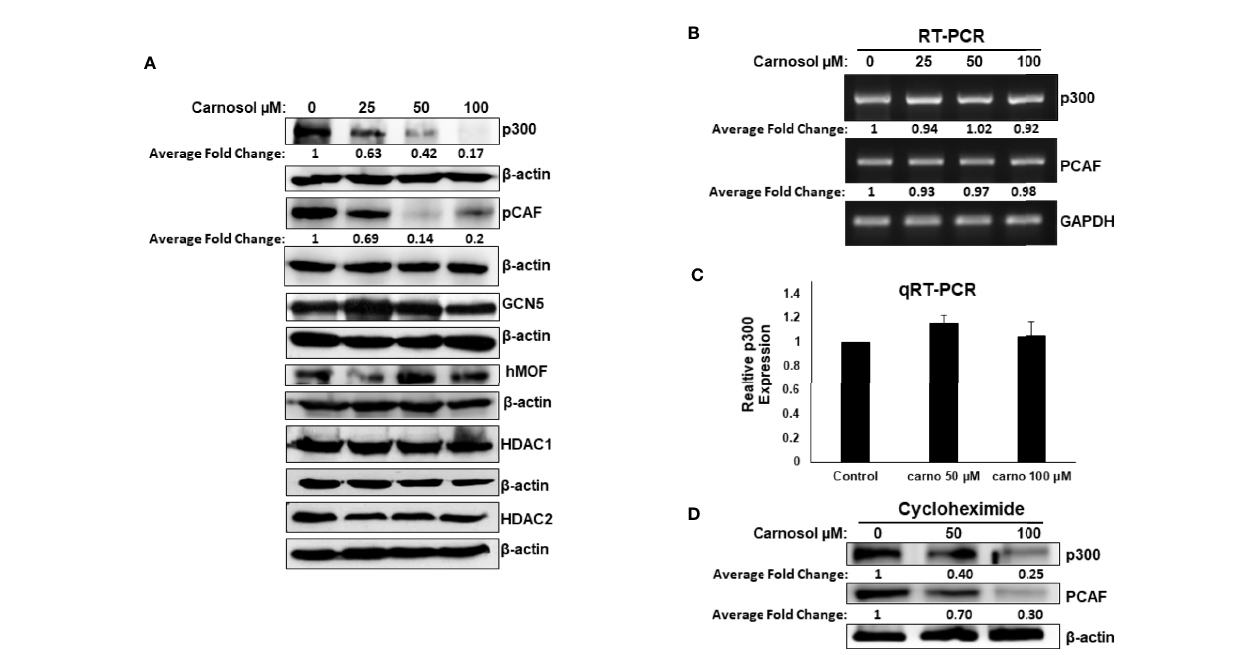
FIGURE 2 | Carnosol downregulates p300 and PCAF in MDA-MB-231 cells. (A) Downregulation of p300 and PCAF protein levels in carnosol-treated MDA-MB-231 cells. MDA-MB-231 cells were treated with vehicle (DMSO) or indicated concentrations of carnosol and whole cell lysates were resolved in 6% SDS-PAGE and subjected to Western blot analysis for the indicated proteins. Data shown are representative of three independent experiments. (B, C) carnosol does not affect the levels of p300 and PCAF mRNA transcripts. Total RNA from carnosol-treated and untreated cells were used to amplify the PCAF and p300 transcripts by RT- and qRT-PCR. RT- and qRT-PCR were repeated twice. (D) Downregulation of p300 and PCAF proteins by carnosol in cycloheximide-pre-treated cells. Cells were pre- treated with cycloheximide, an inhibitor of de novo protein synthesis, for 2 h and then treated with or without carnosol (50 and 100 µM). Whole cell lysates were collected and subjected to Western blot for p300 and PCAF. The intensities of the bands of Wester blots were quanti fi ed using the ImageJ software (National Institute of Health,